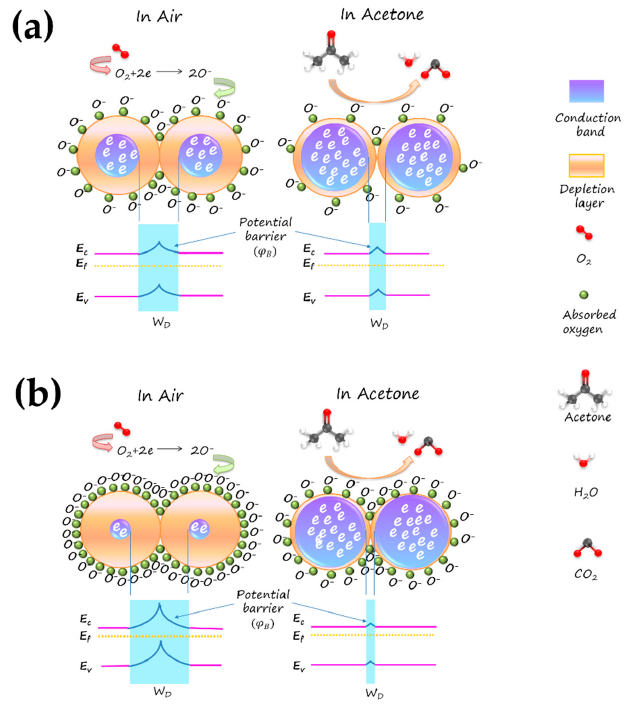
Figure 14. Schematic of acetone sensing mechanism of ( a ) pure SnO 2 and ( b ) N-incorporated SnO 2 samples. SnO 2